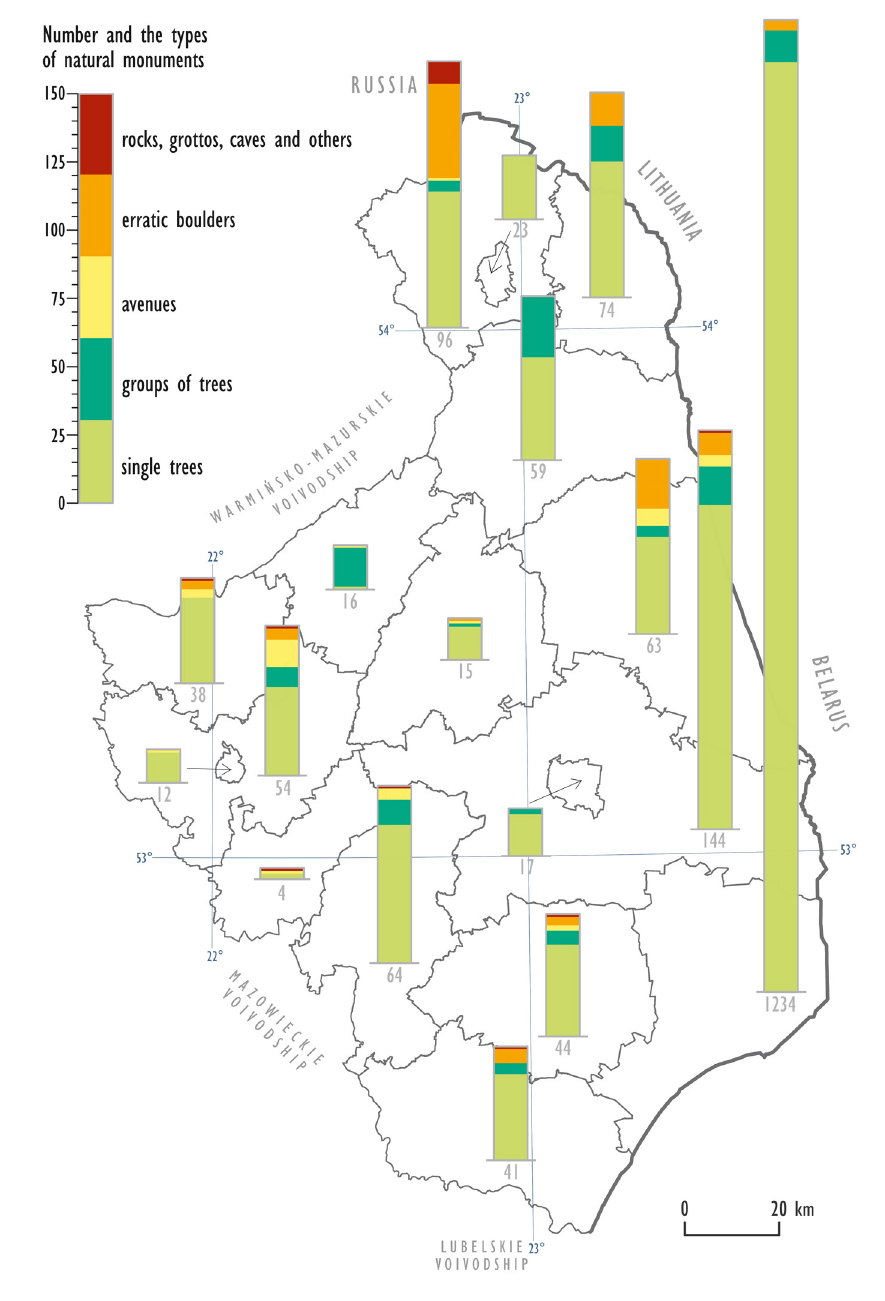
Fig. 11. Number and types of natural